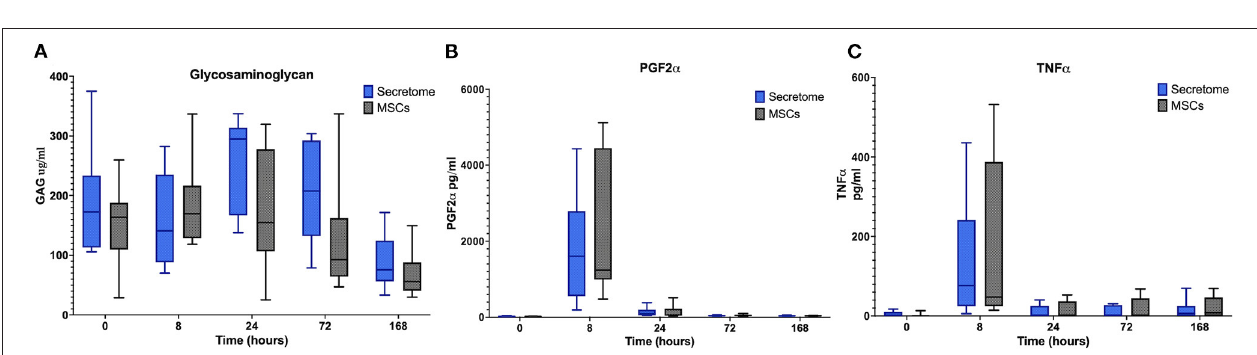
FIGURE 5 | Phase 2 synovial fluid glycosaminoglycan, prostaglandin f2 α and tumor necrosis factor α . (A) Glycosaminoglycan, (B) Prostaglandin F2 α , and (C) Tumor Necrosis Factor α concentrations in synovial fluid over time following induction of inflammation with intra-articular injection of 0.25 ng of LPS in the left and right radiocarpal joints of horses at PIH 2 0 ( n = 8 horses). Joints were treated with either intra-articular mesenchymal stem cell (MSC)-secretome of mesenchymal stem cells (MSCs) (positive control) at PIH 2 2. Boxes depict median and interquartile ranges; whiskers denote minimum and maximum